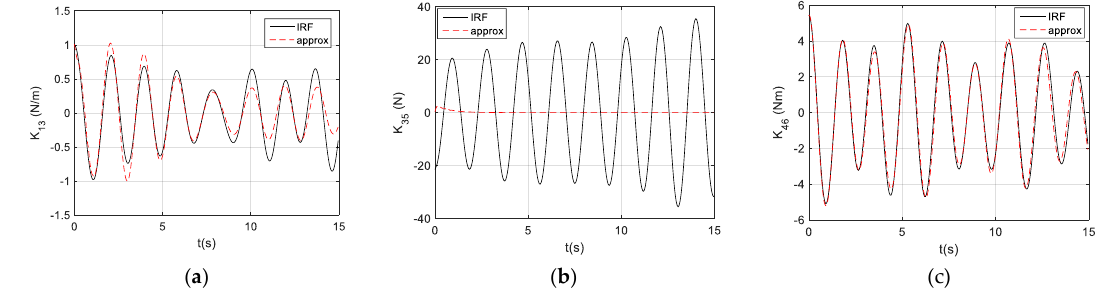
Figure 12. Some weak coupled impulse functions. ( a ) 𝐾 13 ; ( b ) 𝐾 35 ; ( c ) 𝐾 46 .